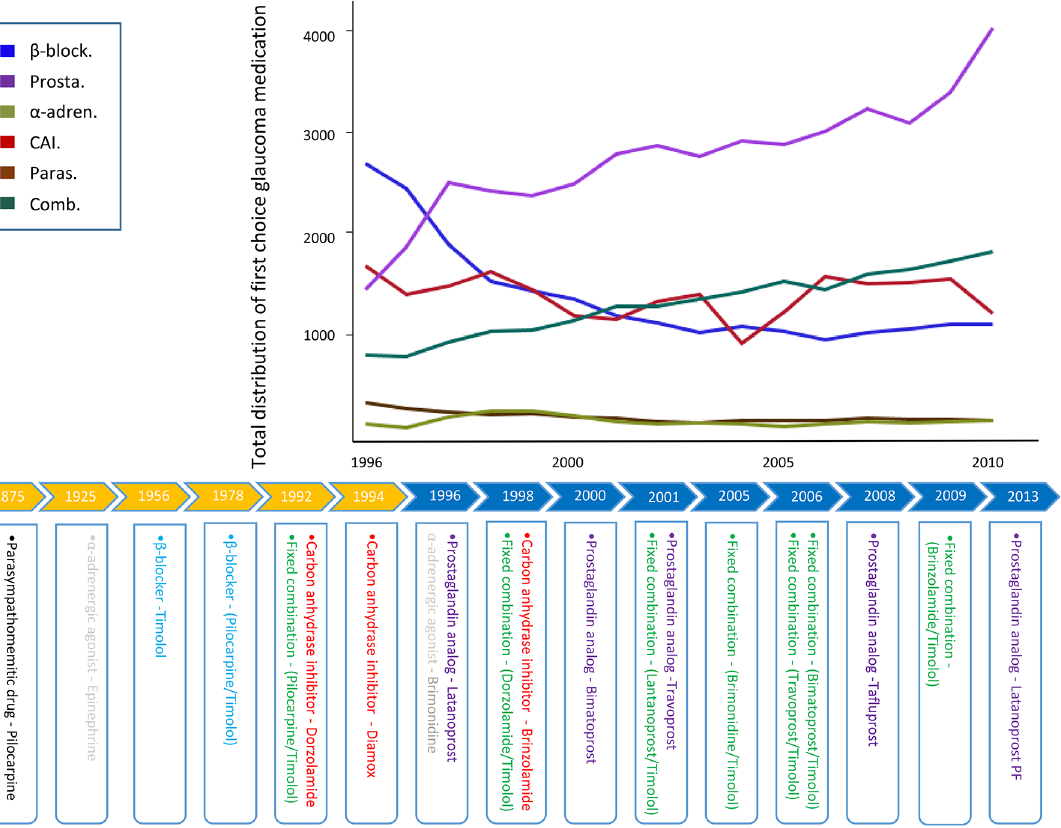
Fig 3. Total distribution of “ first of choice ” glaucoma medication in Denmark in the period from 1996 to 2011. The distribution of “ first of choice ” medication is shown throughout the study period. The use of β -blockers has decreased ( p < 0.001), whereas the use of prostaglandin analogs and combination drugs has increased in the studied period ( p < 0.001). The lower figure shows the time line of the introduction of glaucoma medication (modified from European Guidelines, 4 th edition). Abreviations: β -block., β -blockers; Prostagl., prostaglandin analogs; α -adren., α 2-adrenergic agonists; Paras., parasympathomimetic drugs; CAI, carbon anhydrase inhibitors; Comb., combination drugs.